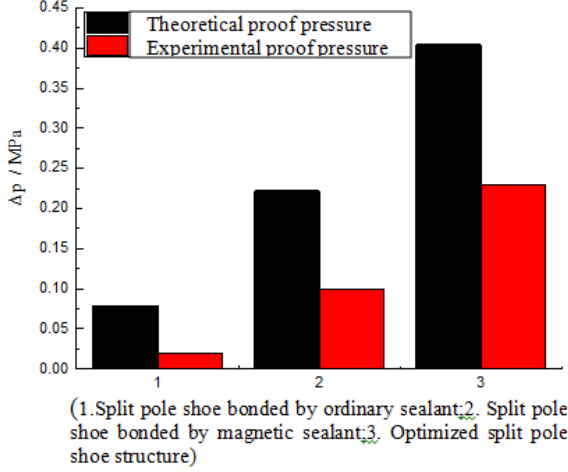
Fig. 14 The comparison of the simulation and theoretical results of pressure resistance for the pole shoes in different